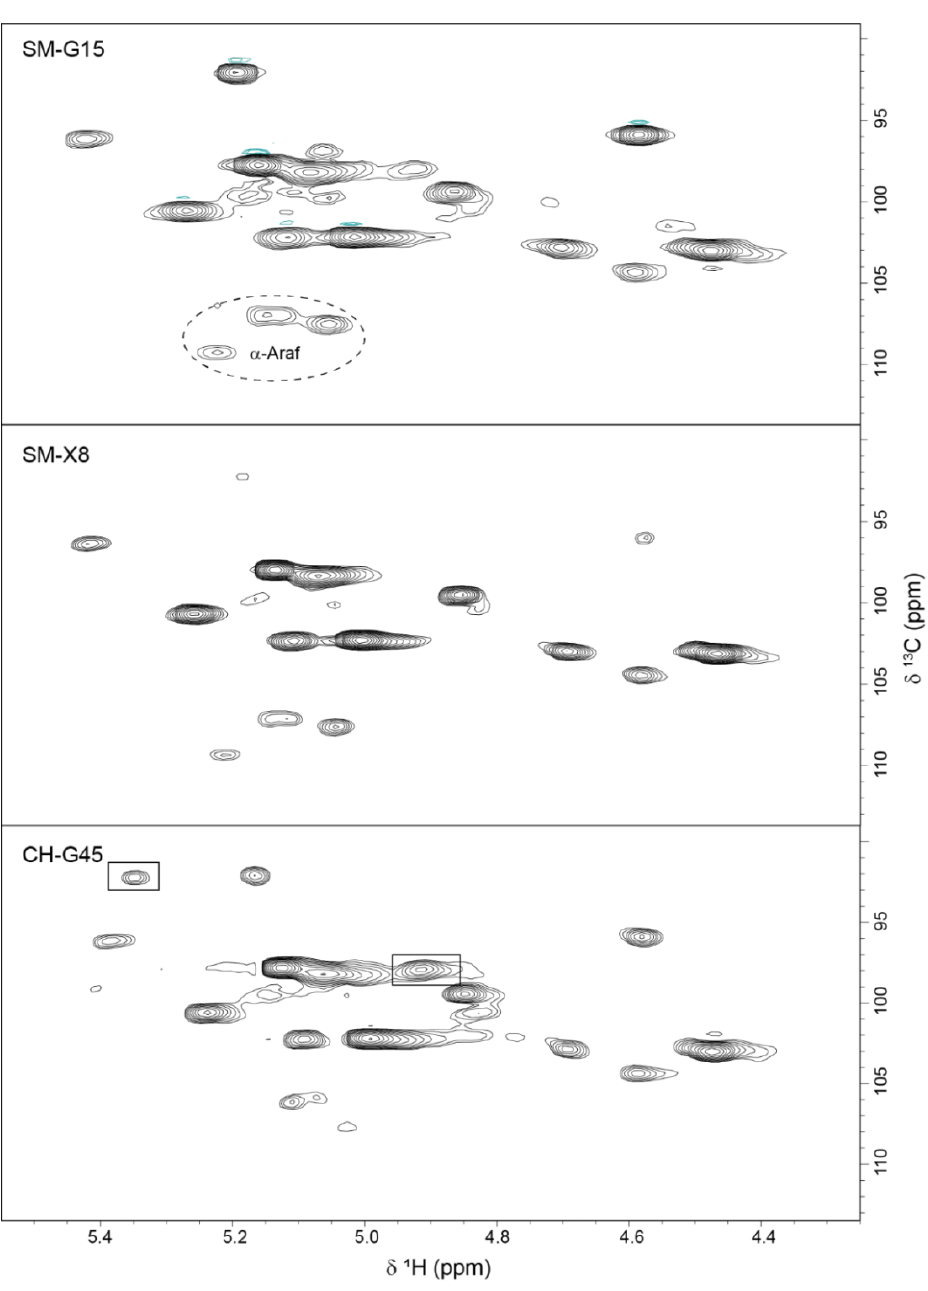
Figure 6. Anomeric region of 2D 1 H- 13 C HSQC NMR spectra of EPS produced by cultivation of B. atrophaeus BU4 in glucose- (SM-G15) and xylose-based (SM-X8) synthetic media and in a quinoa stalk cellulosic hydrolysate